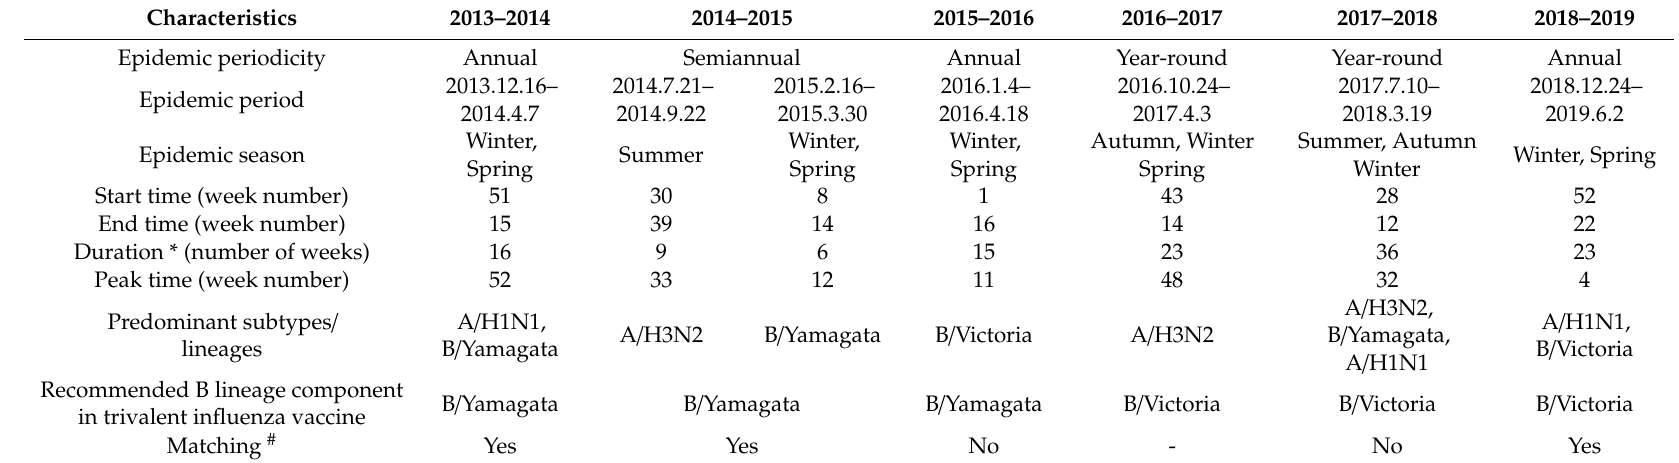
Table 3. Characteristics of seasonal influenza virus epidemics and matching with the trivalent influenza vaccine in Yichang, Hubei, 2013–2019.